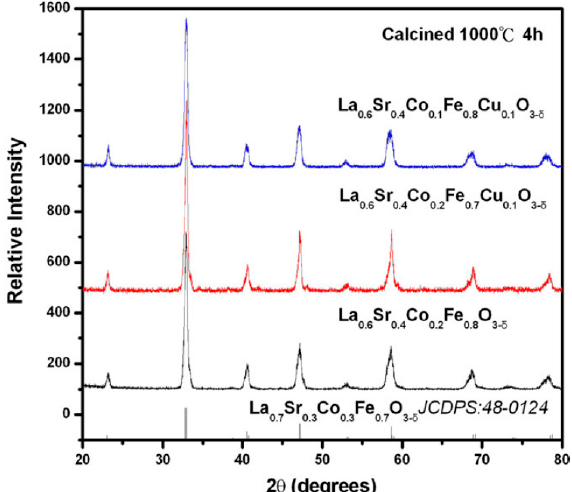
Figure 4. XRD patterns of La 0 . 6 Sr 0.4 Co 0.2 Fe 0.8 O 3−δ , La 0.6 Sr 0.4 Co 0.2 Fe 0.7 Cu 0.1 O 3−δ and La 0.6 Sr 0.4 Co 0.1 Fe 0.8 Cu 0.1 O 3−δ powders calcined at 1000 °C for 4 h. (Reprinted with permission from [42], 2011,